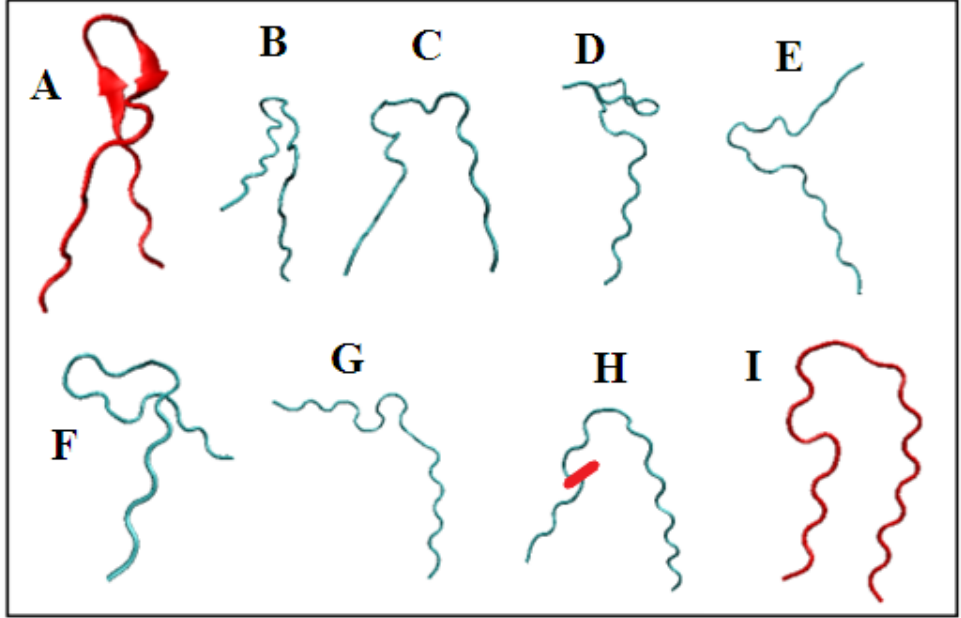
Figure 13. The proposed model applied to the fragment 11–35 of transthyretin (1DVQ). ( A , I )—the structures as observed in 1DVQ and 6SDZ, respectively, shown in red. ( B – H )—step-wise changes in structure according to scenario described above in the text. The stepwise changes in the Phi and Psi angles are shown in Figure 12. The red dash on H—the single position of Phi and Psi angles different in respect to the final structure ( I ). The difference shown in Figure 12H.